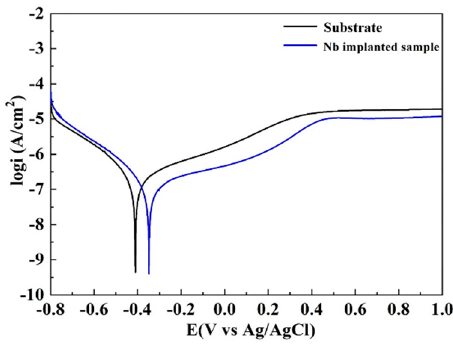
Figure 4. The potentiodynamic polarization curves of the untreated and treated samples in Ringer’s Figure 4. solution.